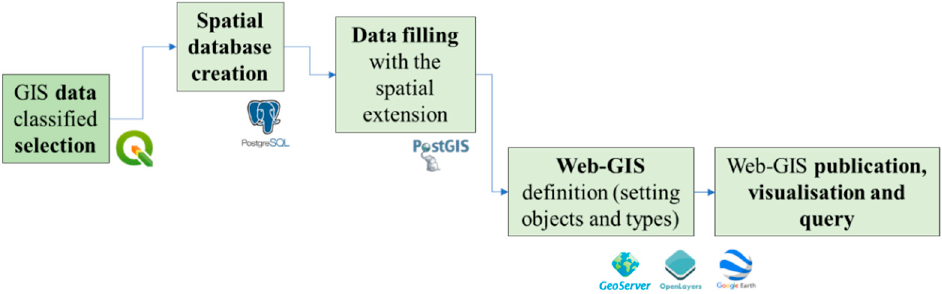
Figure 10. Data visualisation and querying